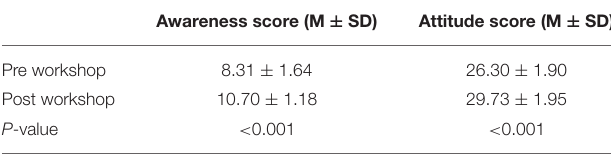
TABLE 2 | Mean and standard deviation (M ± SD) of the clergy’s awareness and attitude pre- and post-workshop.